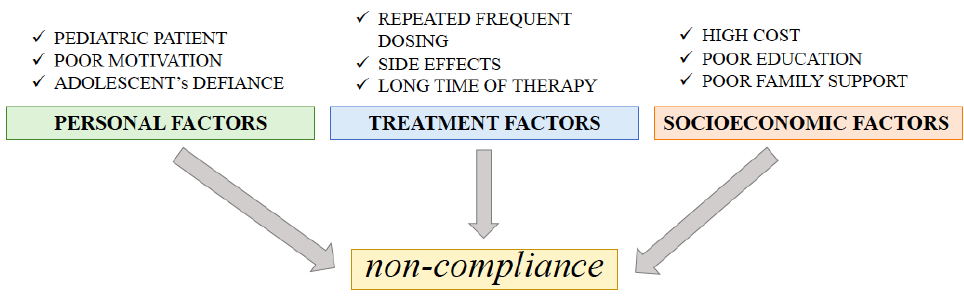
Figure 2. The main factors causing noncompliance in transplant patients